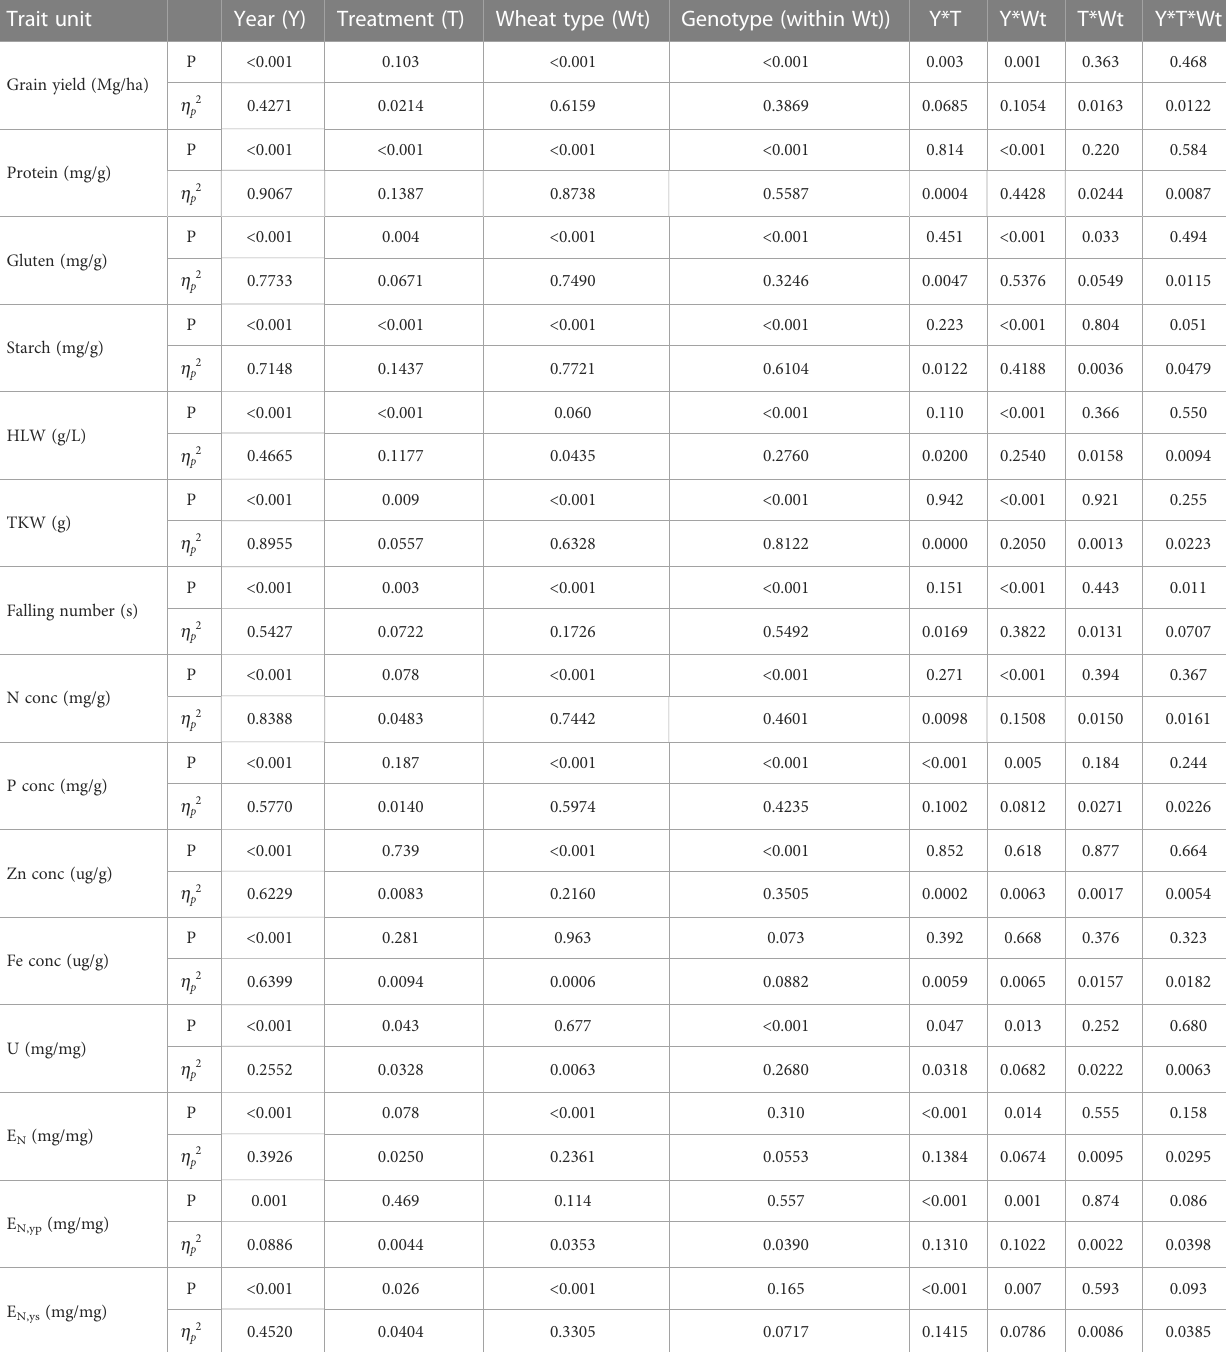
TABLE 3 Analysis of variance (ANOVA) p-value (P) result for grain yield and quality traits and their equivalent effect sizes ( h p 2 ) for fi xed effects. Trait